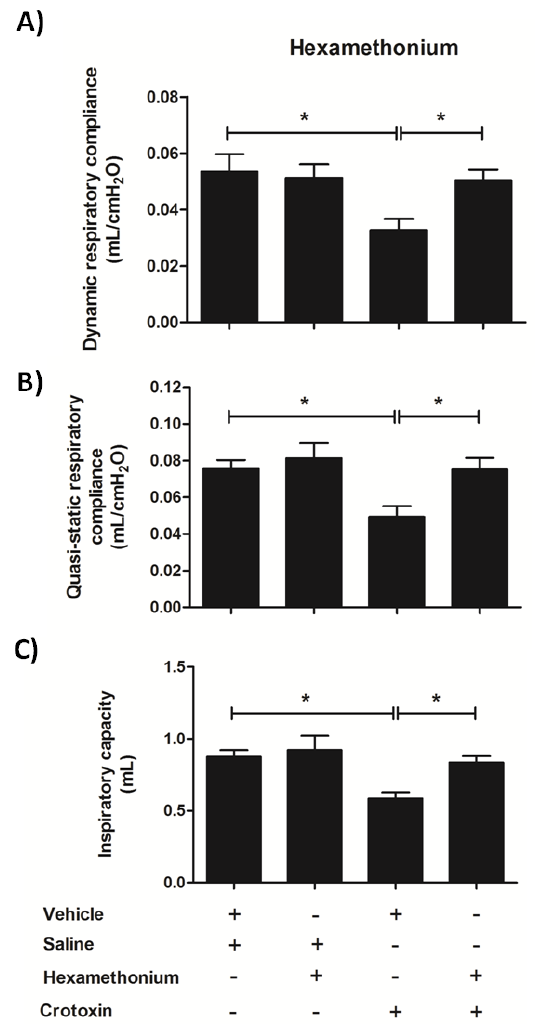
Figure 9. Effect of hexamethonium on lung mechanics of CTX-treated mice. Mice were treated with hexamethonium (10 mg / Kg i.v.) 30 min before CTX (300 µ g / Kg s.c.) administration. After 12 h, we used a small animal ventilator to determine the respiratory mechanics parameters in vivo. ( A ) Respiratory system compliance. ( B ) Quasi-static compliance. ( C ) Inspiratory capacity. The results are representative from two independent experiments ( n = 7–8 animals / group). * p < 0.05—one-way ANOVA followed Tukey’s multiple comparison test.